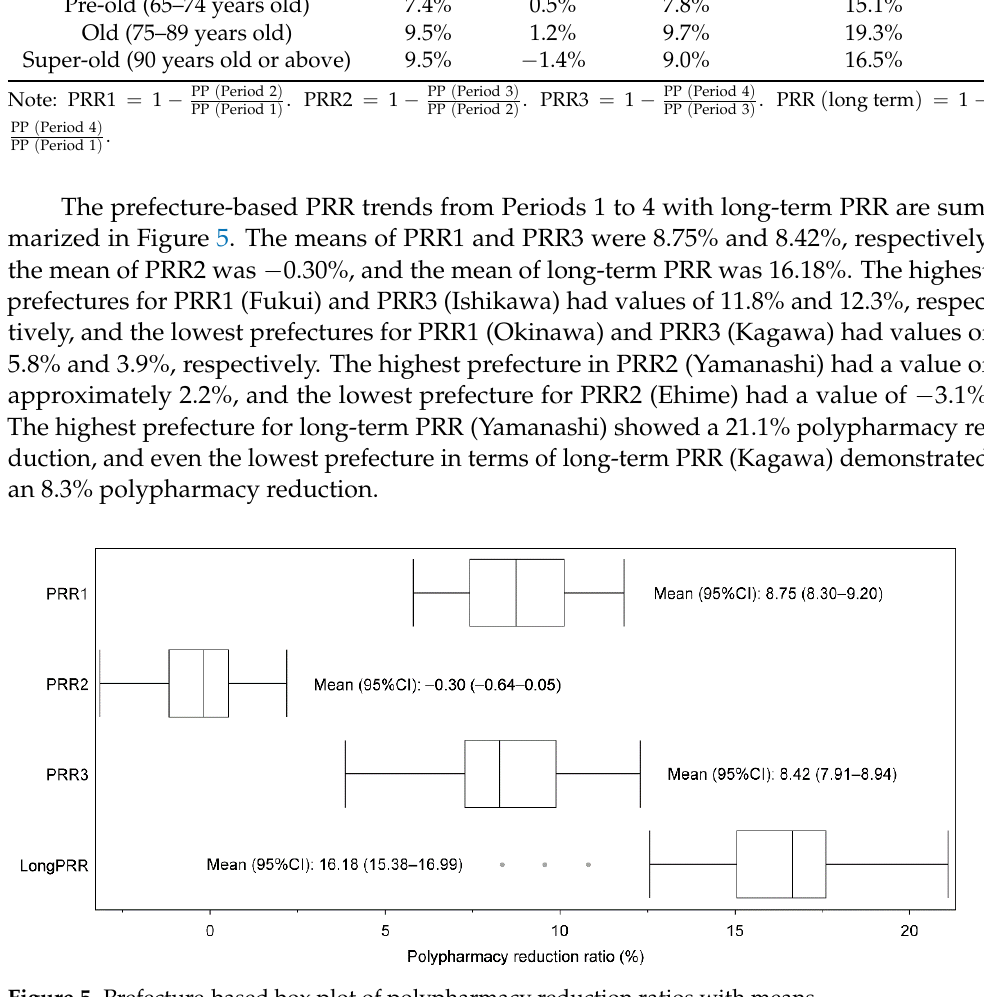
Figure 5. Prefecture-based box plot of polypharmacy reduction ratios with means.